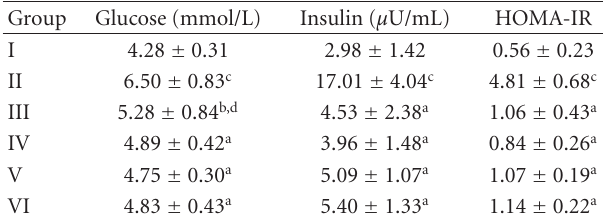
Table 1: E ff ect of vitamins A, C, and E on glucose, insulin, and insulin